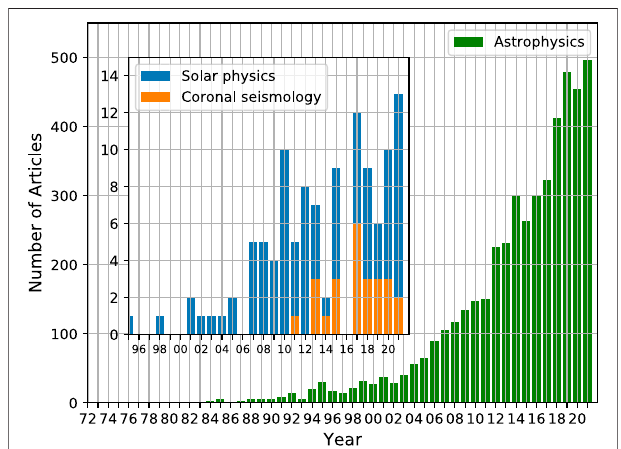
FIGURE 1 | Bar plots representing the yearly number of referred articles employing Bayesian analysis techniques in the fi eld of astrophysics, the branch of solar physics, and the research area of coronal seismology. At the time of writing (November 2021), the total number of articles amounts to 4678 in astrophysics, 114 in solar physics, and 25 in coronal seismology. Source:NASAAstrophysicsDataSystem(ADS),digitallibraryoperatedbythe Smithsonian Astrophysical Observatory